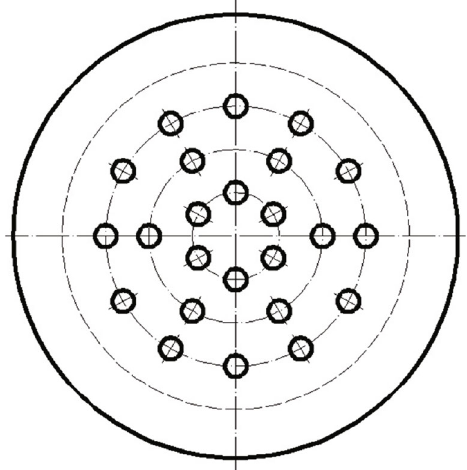
Figure 6: The schematic diagram of the transport pipeline